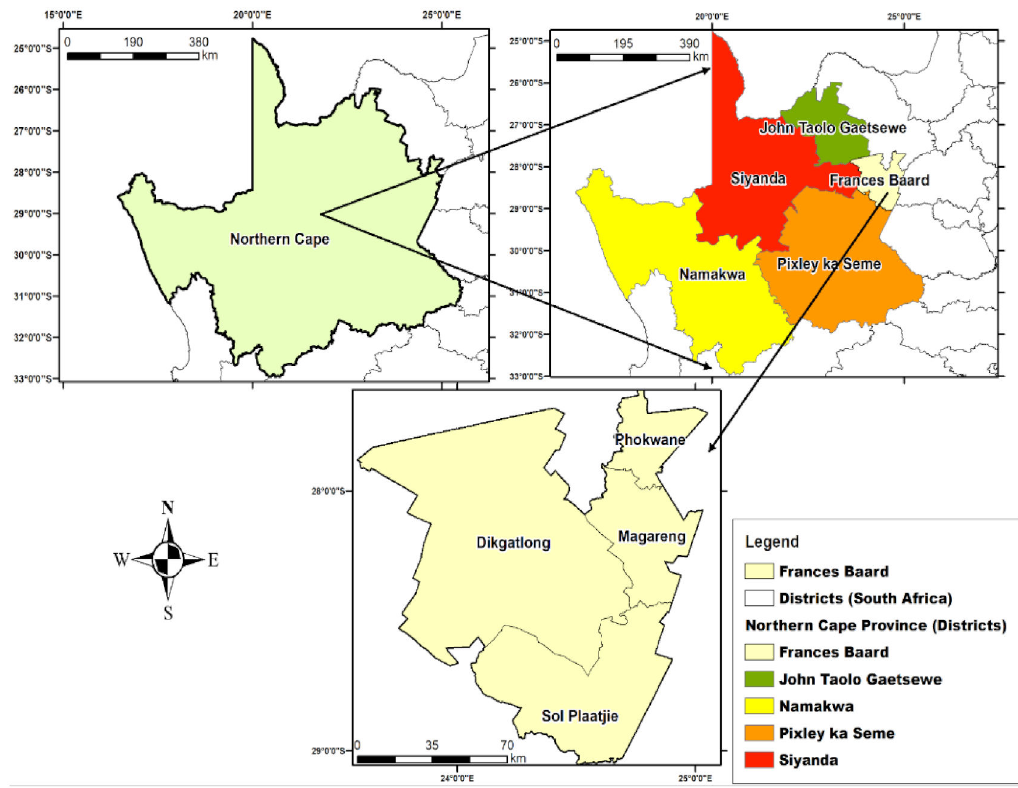
Figure 2. Maps of South Africa highlighting Northern Cape Province, district municipalities of the Northern Cape, and the four local municipalities of Frances Baard District Municipality. Source: FBDM [38].